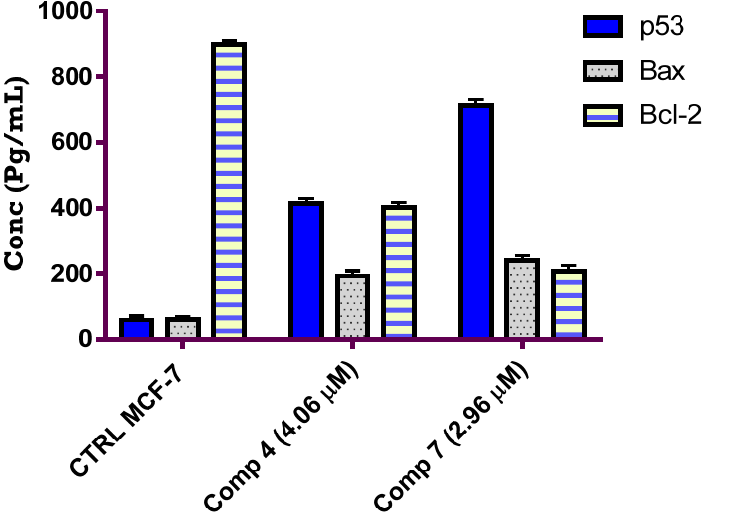
Figure 6. Effect of compounds 4 and 7 on apoptosis-associated proteins after 48 h treatment in MCF-7 cells.